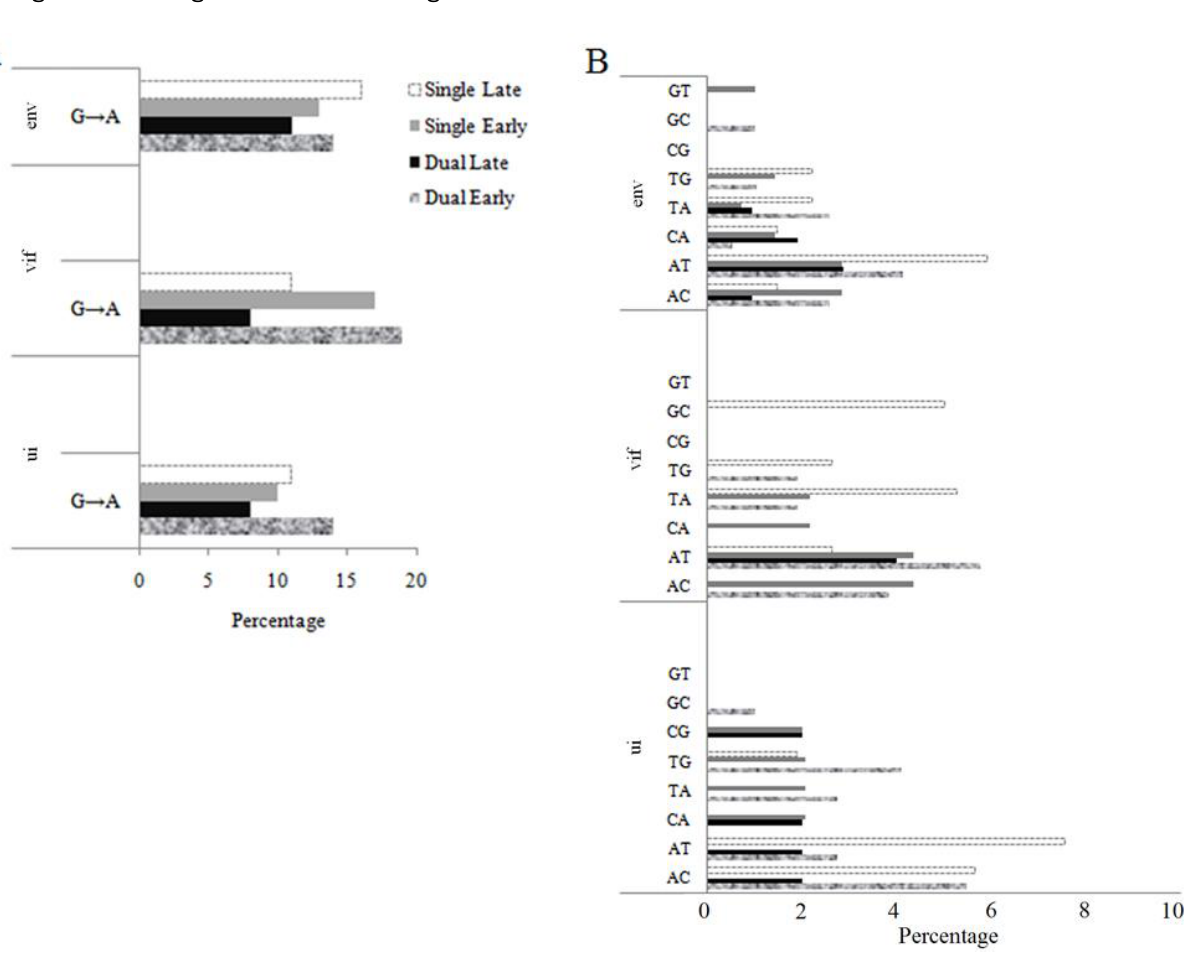
Figure 4. Percentage of substitutions in early and late populations in FIVC sequences from single and dual infections. ( A ) Percentage of total substitutions in each gene that are G to A substitutions. Dual late FIVC genomes have the lowest percentage of G to A substitutions. ( B ) Percentage of total substitutions in each gene that are each possible transversion. The di-nucleotide symbol indicates that the first nucleotide is replaced by the second, e.g., GT indicates a G to T substitution. Data are shown for three genes; ui is the 3' end of the pol gene encoding dUTPase and